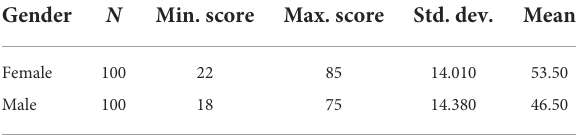
TABLE 6 Learners’ reading comprehension performance. TABLE 7 Correlation between learners’ reading comprehension performance and HOTS.